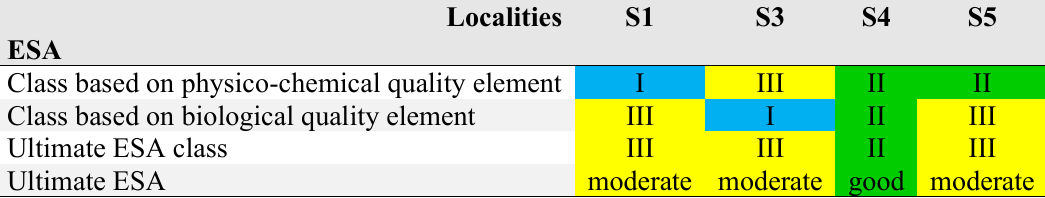
Table 5. Ecological status assessment (ESA) of the Samokovska River based on physico-chemical and biological quality elements in October 2018 (water body Type